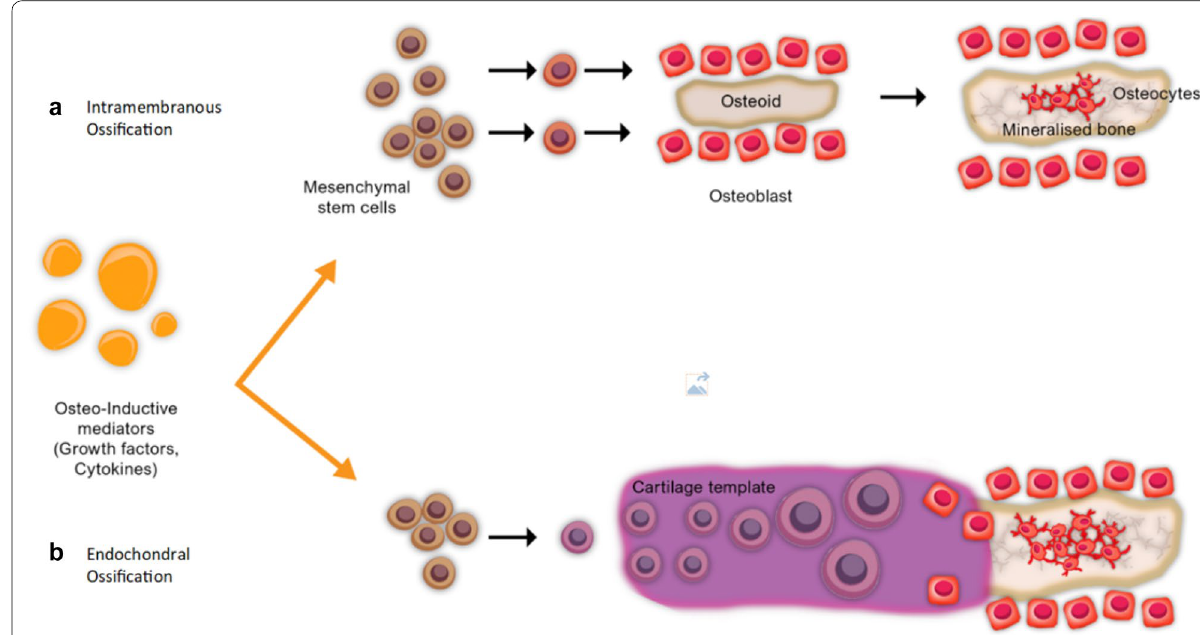
Fig. 3 Diagrammatic representation of ossification: a Intramembranous ossification. Osteoinductive mediators induce osteogenic MSCs to differentiate into osteoblasts, which lay down osteoid (collagen-1 rich); this mineralises to form an ossification centre, whence mineralisation extends. There is terminal differentiation into osteocytes, becoming entombed in the bone matrix. b Endochondral ossification. Osteoinductive mediators induce osteogenic MSCs to differentiate into chondrocytes; a cartilage matrix is secreted which forms the template for endochondral bone formation. Chondrocytes then undergo hypertrophic differentiation and mineralise the surrounding matrix. They eventually undergo apoptosis—resulting in vascular invasion. Invading blood vessels convey osteoblasts which form bone on the cartilage template